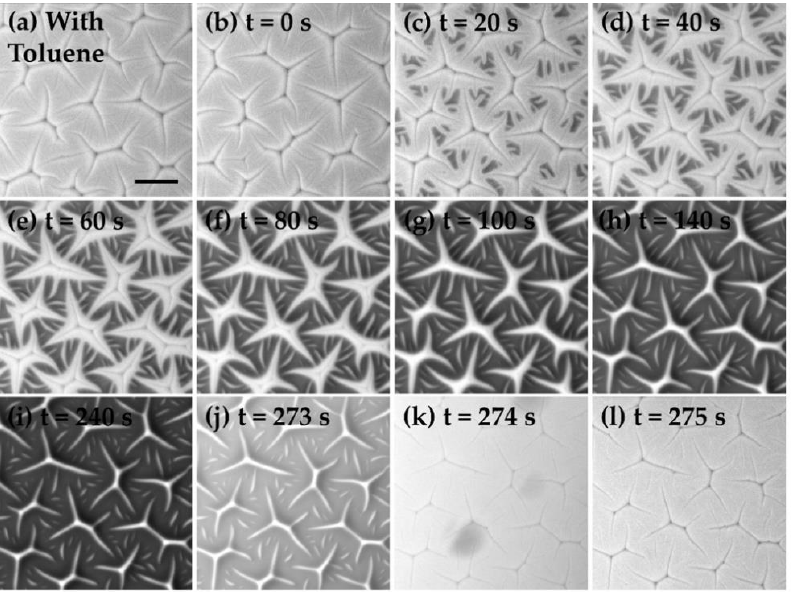
Figure 3. The growth and relaxation dynamics of the instability patterns on a 19-micrometer-thick substrate. ( a ) The sample was initially immersed in toluene. ( b ) At 𝑡 = 0 , the toluene was removed with a pipette. ( c – i ) The relaxation of the gel surface during the drying process. ( j ) The moment when toluene was added again to the gel surface. ( k , l ) The gel surface swelled again in toluene, and the creasing instability reappeared. Scale bar in ( a ): 100 μm.